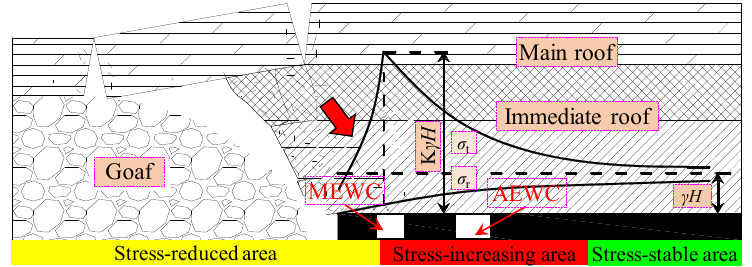
Figure 6. Abutment pressure model in front of the working face.